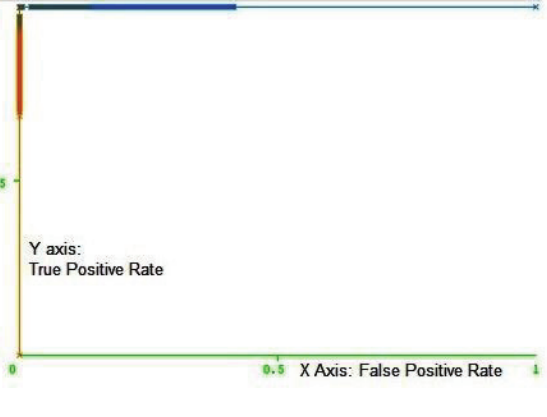
Fig. 2. ROC for - Naïve Bayes, Random Tree and Random Forest (Combined